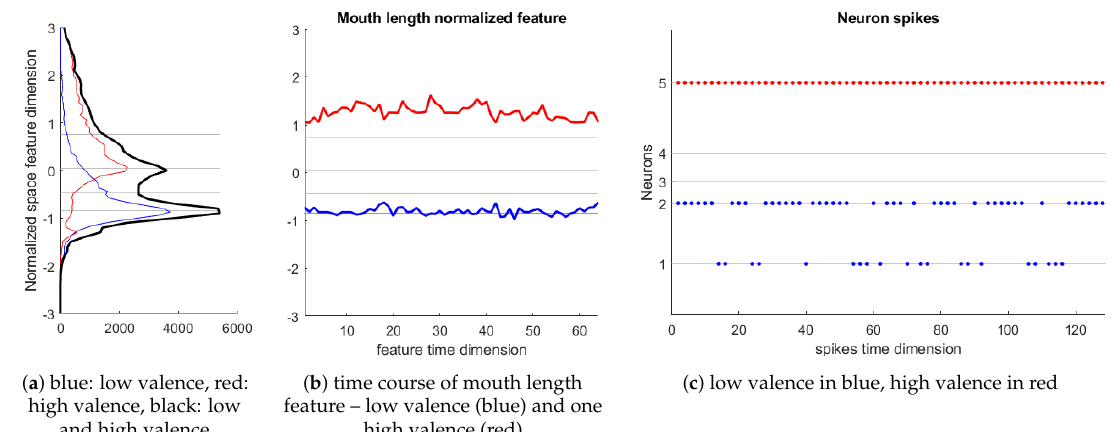
Figure 7. Encoding Continuous feature values to five neurons